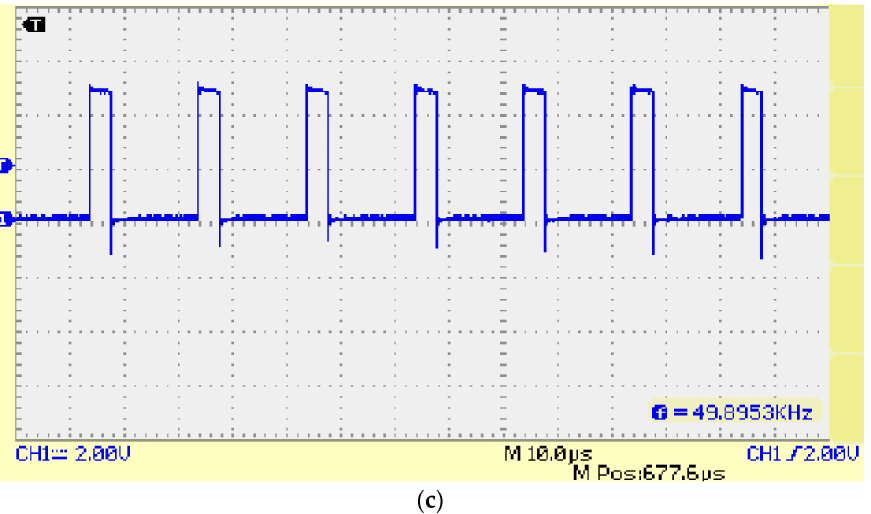
Figure 10. ( a ) Input voltage waveform of the proposed converter, ( b ) output voltage waveform of the proposed converter, ( c ) switching pulse to the switch S 1.